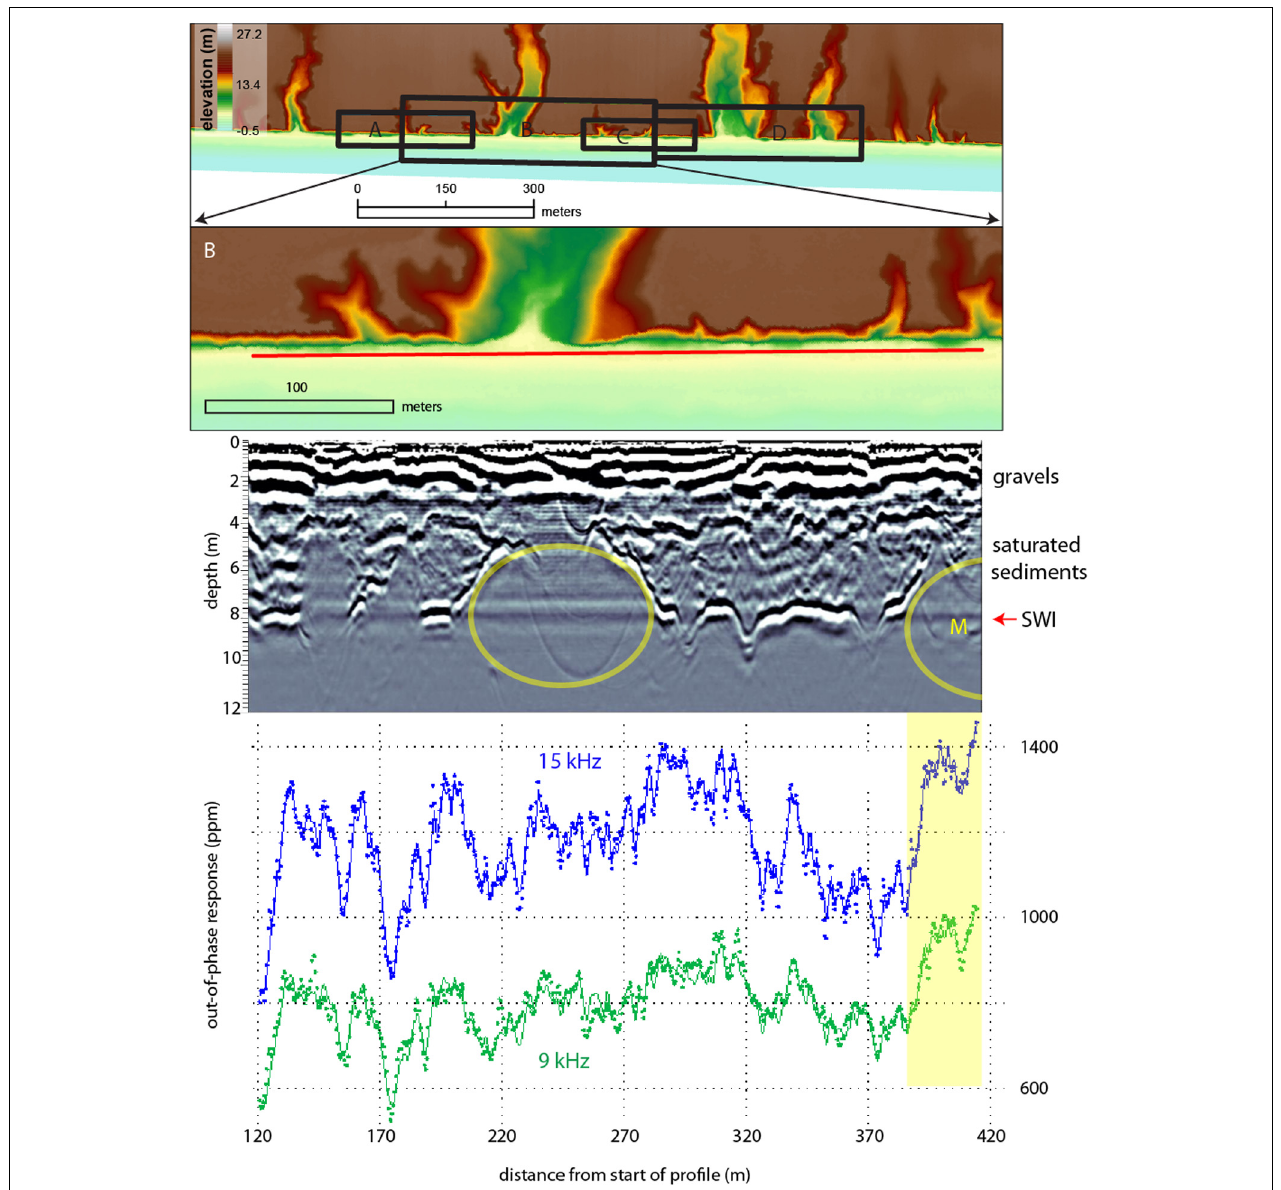
FIGURE 7 | Collocated GPR and EMI survey lines along profile B. Interpreted conduits are marked by yellow circles. Areas where the EMI maxima (highlighted in yellow) match well with the disruption in the radar reflector are marked with an ‘M’ on the GPR section.